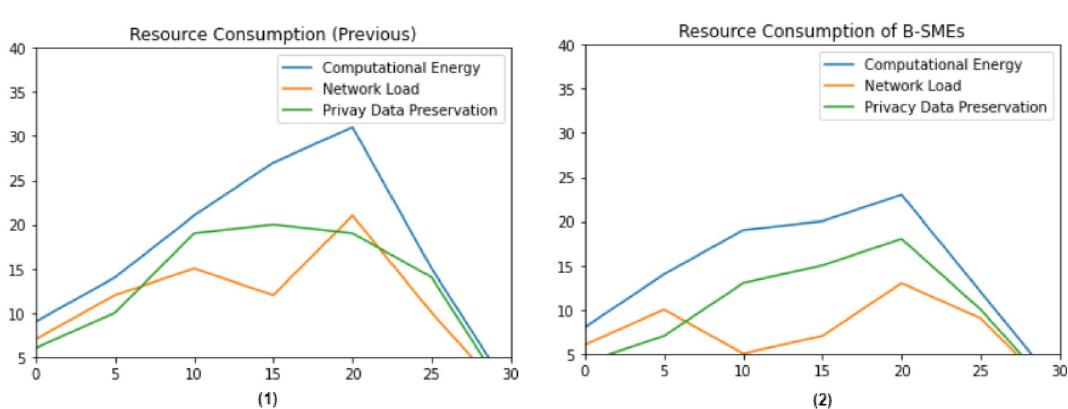
Figure 6. Cost of resource consumption ( 1 ) shows the graph of pervious work, and ( 2 ) shows the graph of the proposed